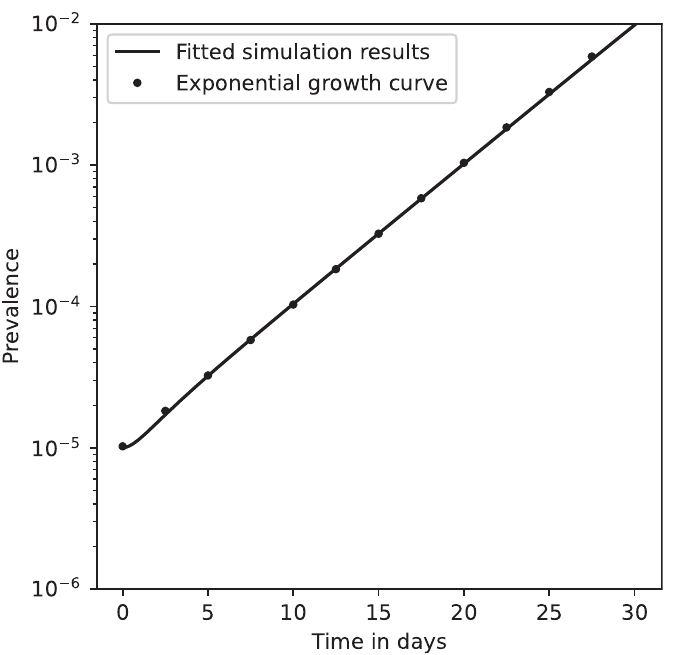
Fig 1. Convergence of model from initial conditions to exponential growth regime. Our model is simulated from initial conditions with starting prevalence 10 − 5 and no background immunity. The exponential curve is callibrated to the prevalence 15 days from the start of the simulation.